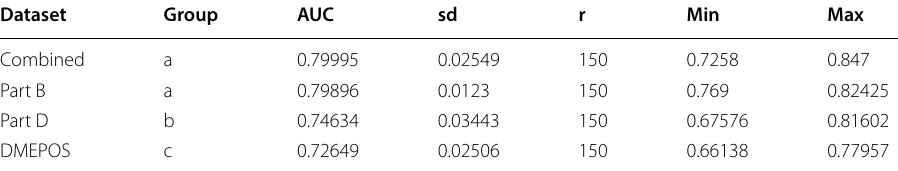
Table 14 Two-factor Tukey’s HSD dataset results over all learners